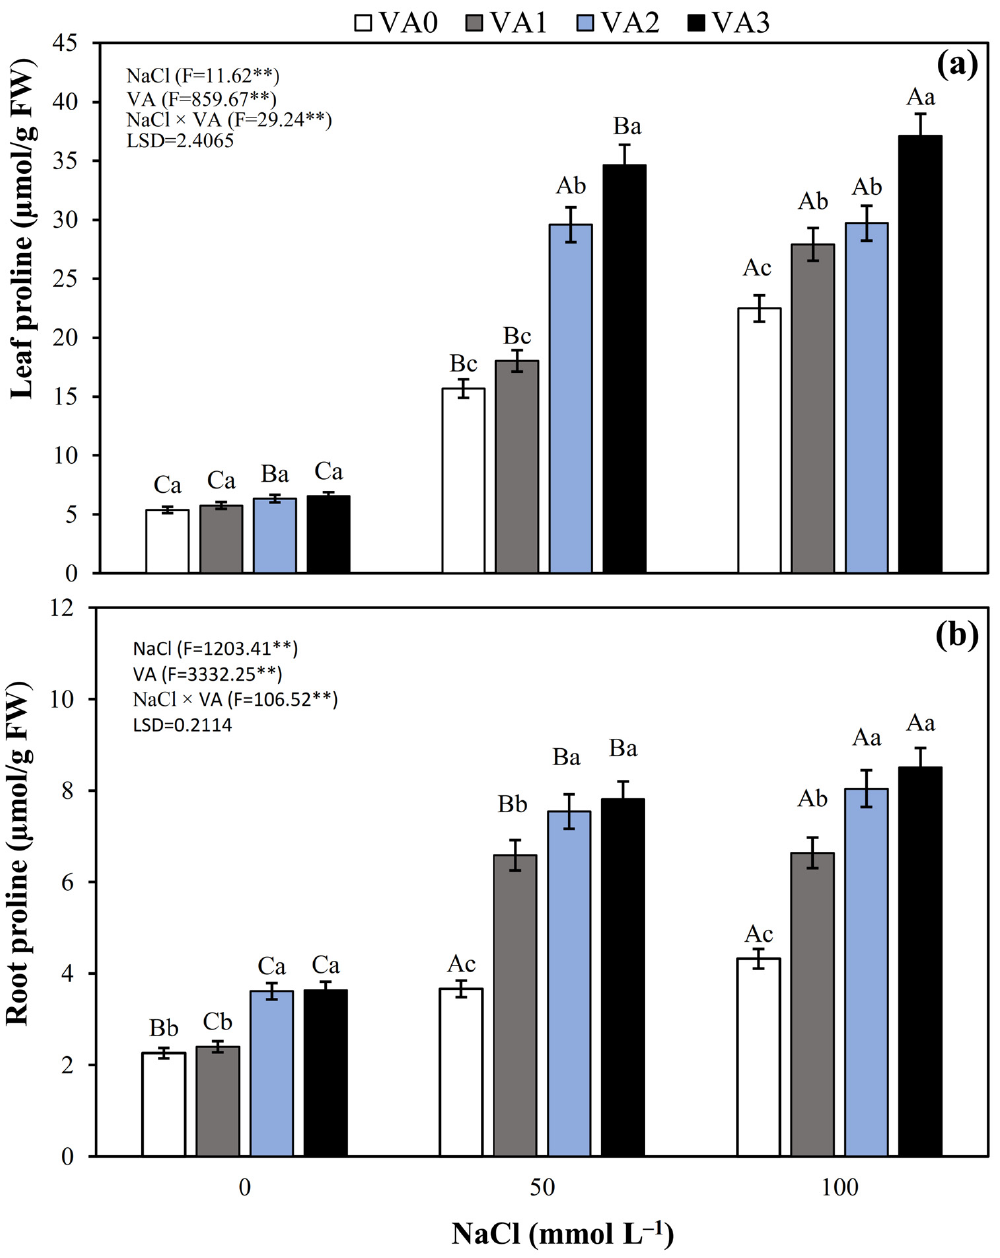
Figure 9. Leaf ( a ) and root ( b ) proline content of soybean plants under different levels of salt stress and VA applications. Plants were submitted to four concentrations of VA (VA0, non-VA application; VA1, 0.4 mL L − 1 ; VA2, 0.8 mL L − 1 ; and VA3, 1.2 mL L − 1 ) and three levels of NaCl (0, 50, and 100 mmol L − 1 ). Data are mean ± SD (n = 5). Uppercase letters above bars indicate significant differences among NaCl concentrations at the same amino acid concentration. Lowercase letters above bars indicate differences among amino acid concentrations at the same NaCl concentration, according to LSD test ( p < 0.05). F values from ANOVA: ** p <